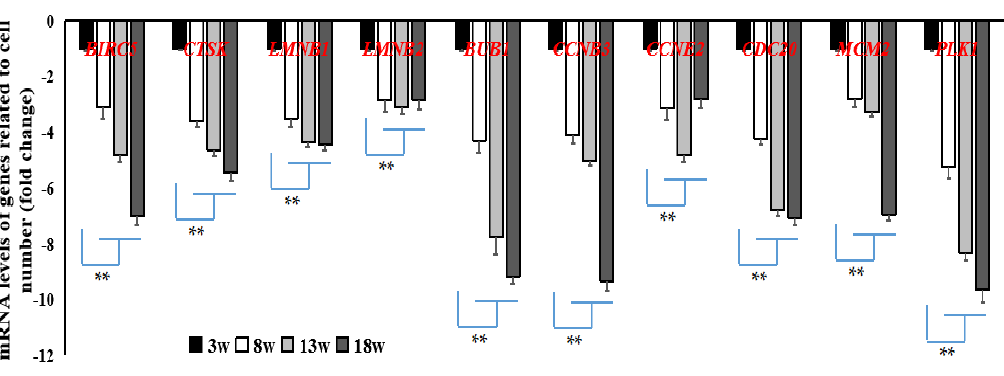
Figure 5. Verification of DEGs related to cell number by quantitative real-time polymerase chain reaction (qRT-PCR). These DEGs were significantly downregulated (** p < 0.01) in breast muscle tissue at 8, 13, and 18 weeks when compared to those at 3 weeks. n = 9.